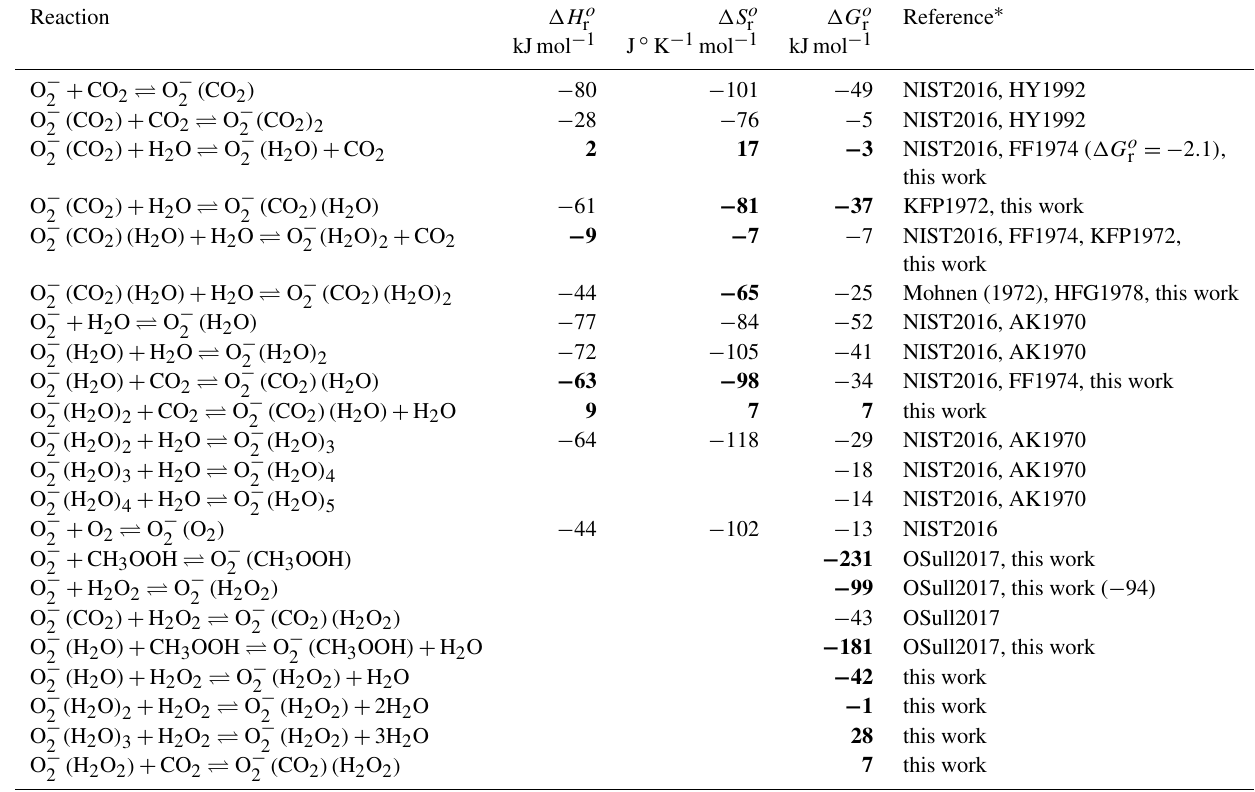
Table A6. Reaction enthalpy, entropy and Gibb’s energy for neutral, ion and ion cluster reactions in the O − oxide system. Note: bold font indicates value derived in this work using published formation and reaction enthalpy, entropy and Gibb’s